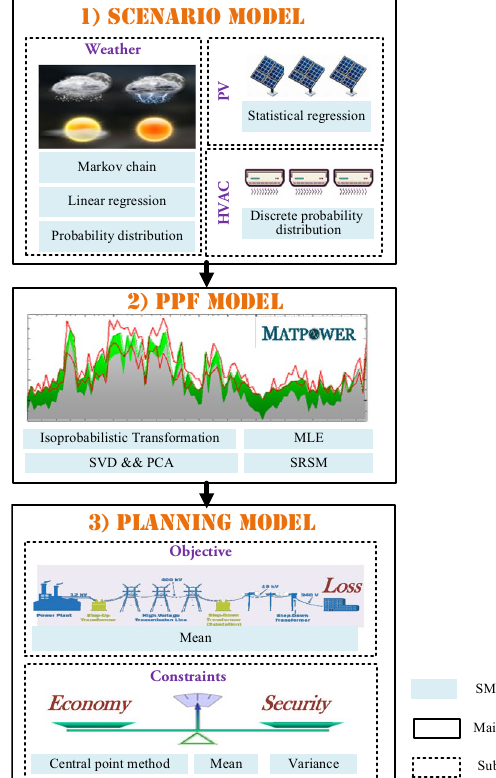
Fig. 1 Bilateral uncertainty in distribution networks Fig. 2 SML-based simulation